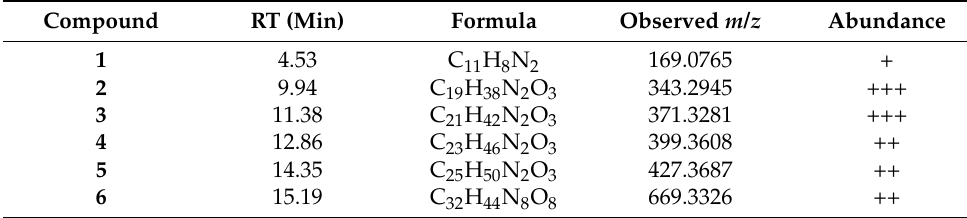
Table 5. The LC-MS/MS profile of FEA-3 sub-fraction.